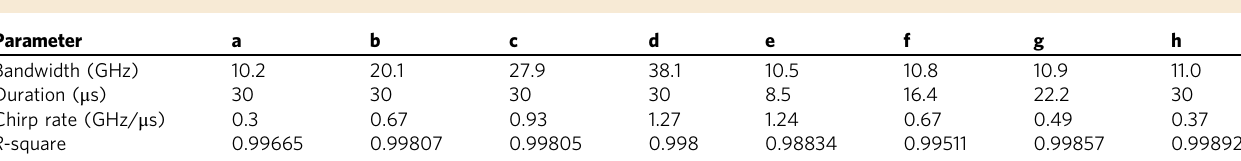
Table 1 Summary of the parameters of the generated LCMWs in Fig. 5.